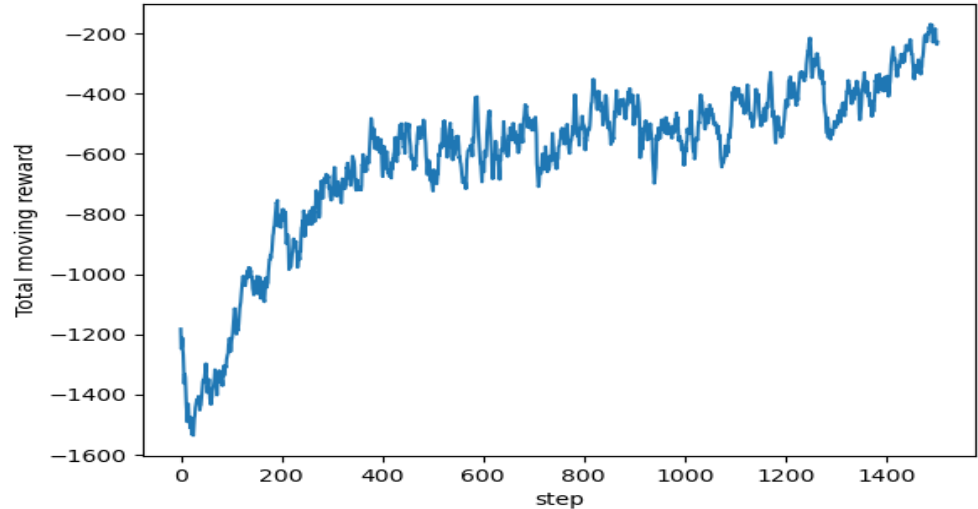
Figure 10. Training neural networks to achieve empirical returns. Represents the increasing reward value